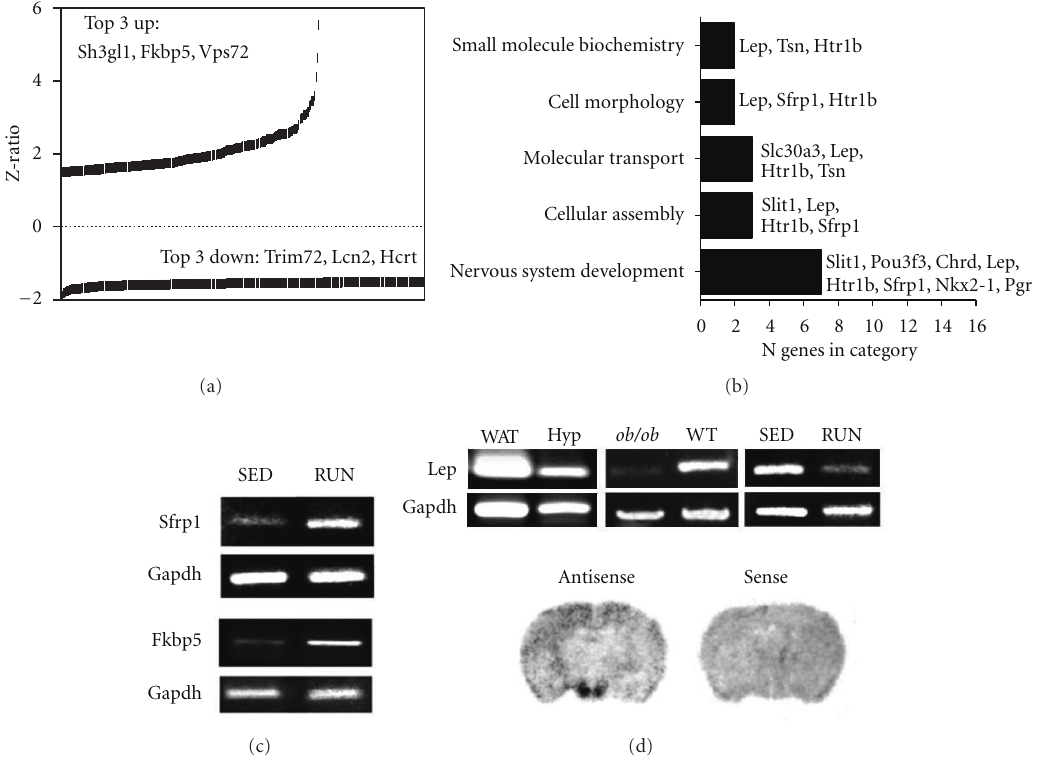
Figure 4: Wheel running influences hypothalamic gene expression and pathway activation in C57Bl/6 mice. (a) Z -ratios for gene transcripts up- or downregulated following voluntary wheel running in C57Bl/6 mice. Fkbp5, FK506 binding protein 5; Vps72, vacuolar